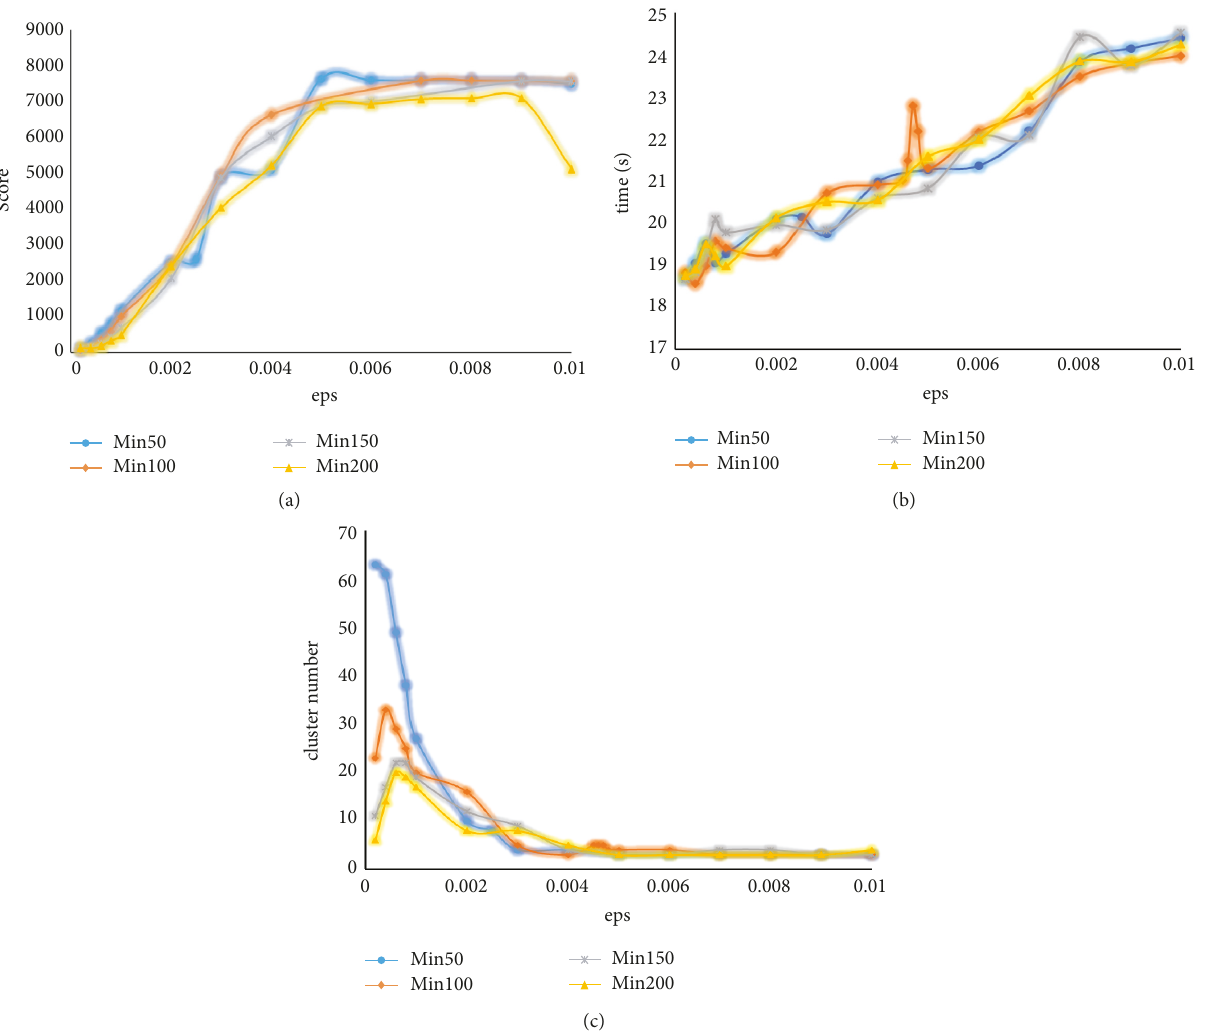
Figure 10: DBSCAN performance evaluation: (a) Calinski-Harabasz Index score; (b) clustering time; (c) cluster number.